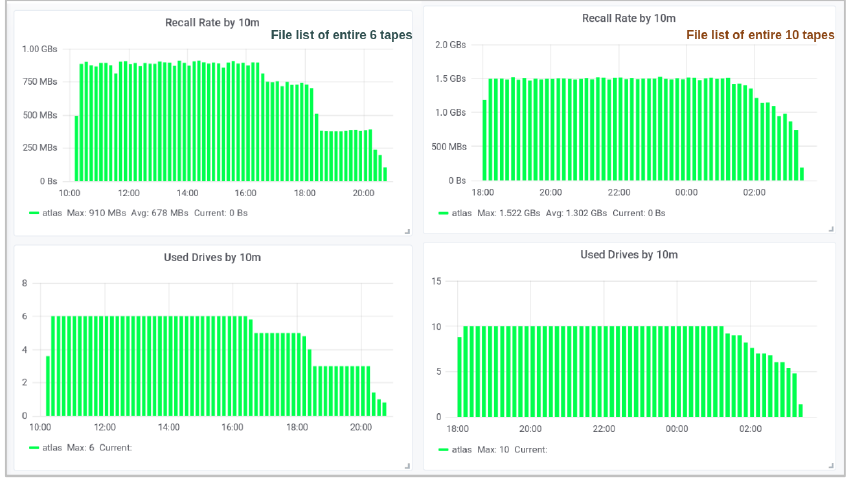
Figure 4: Read the file list of the entire tapes (6 and 10 tape cartridges)